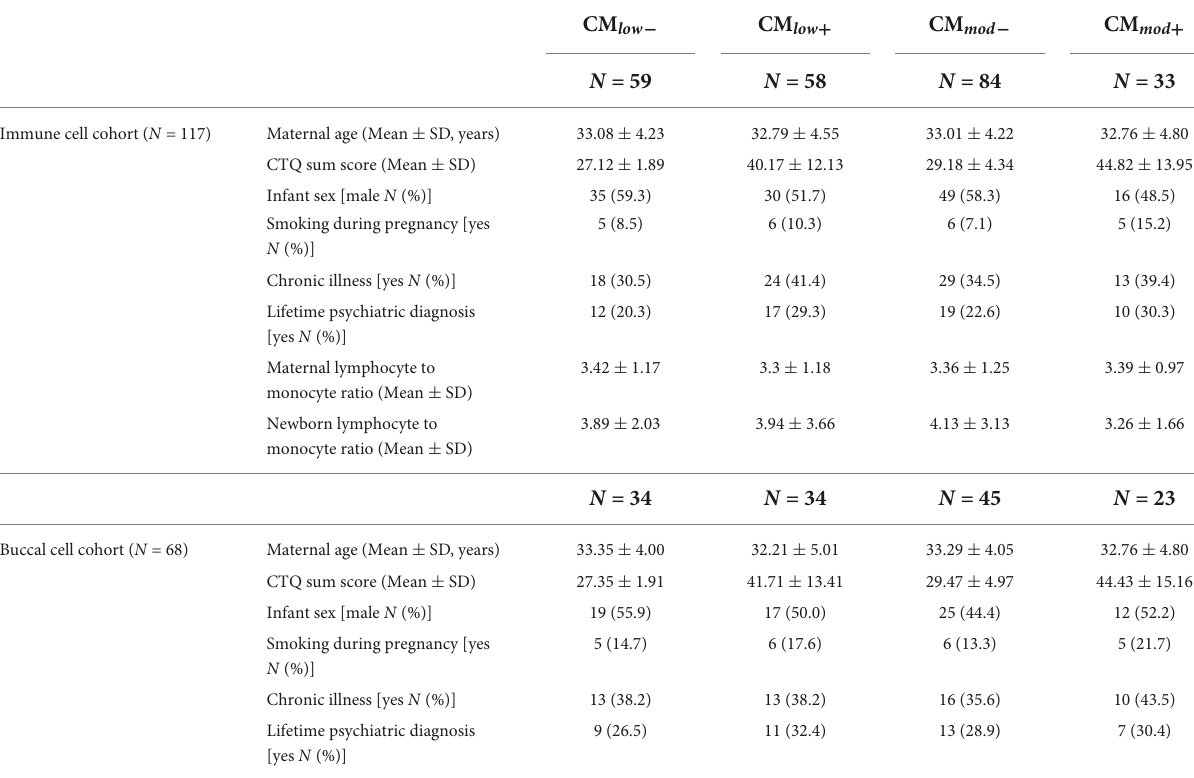
TABLE 1 Sociodemographic and health information in mother-newborn dyads in immune and buccal cell cohorts, categorized according to low and moderate childhood maltreatment (CM) severity